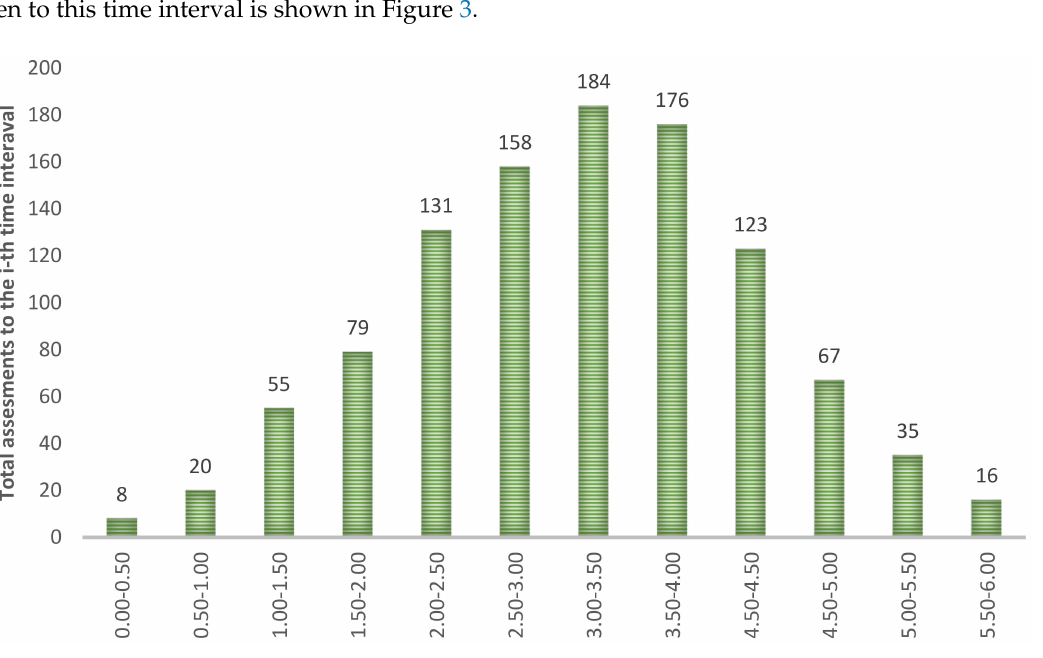
Figure 3. The histogram that represents the assessment of experts concerning the distribution of the recognizing information